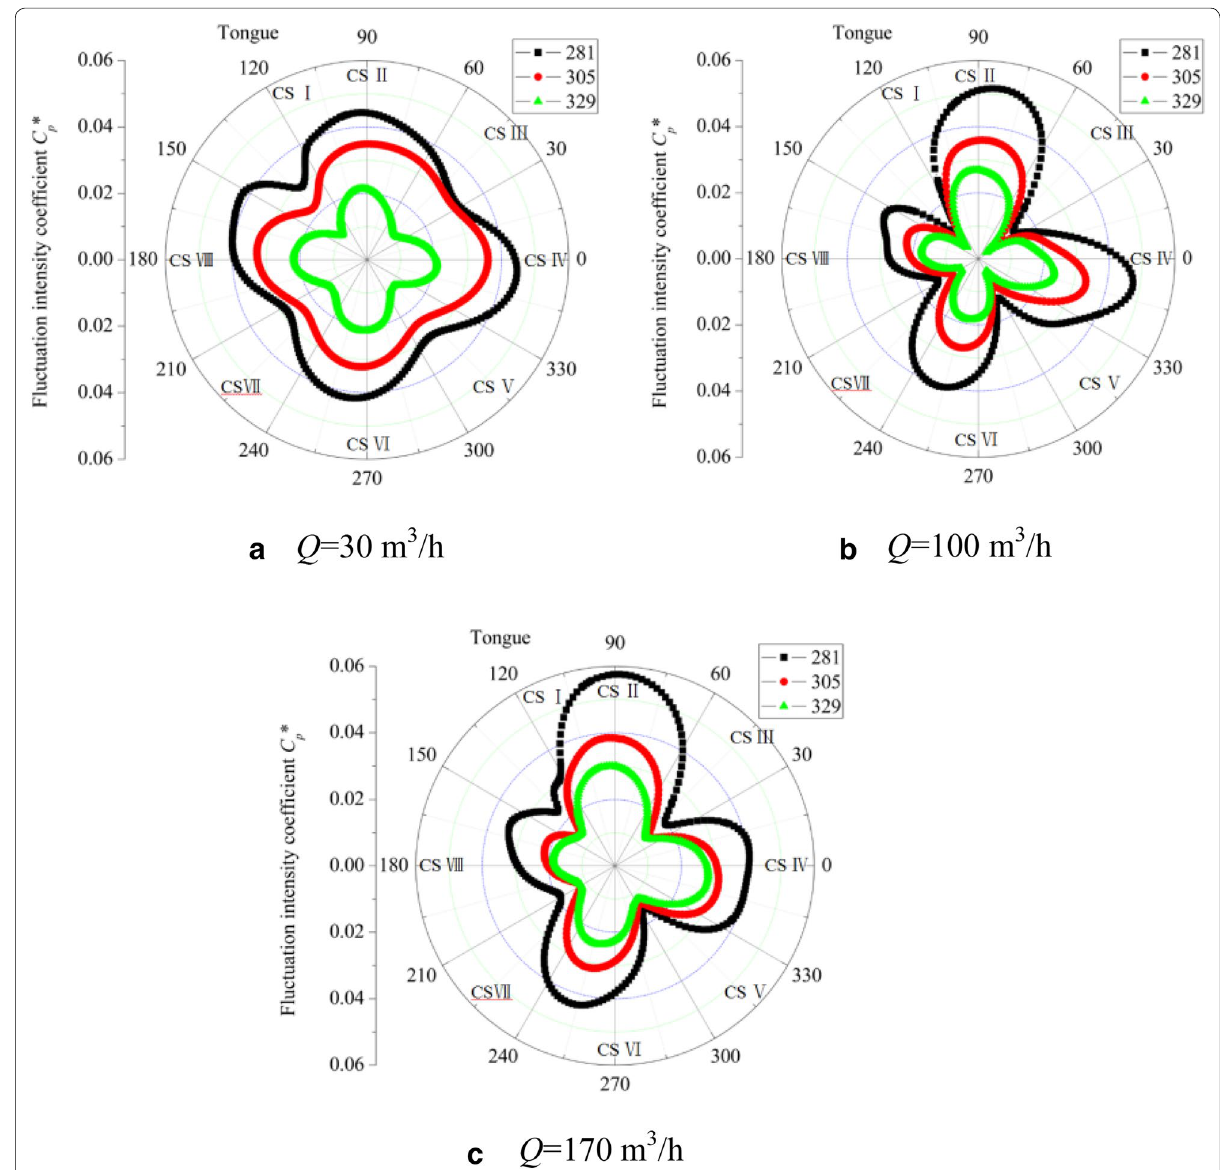
Figure 14 Distribution of fluctuation intensity coefficient at volute casing